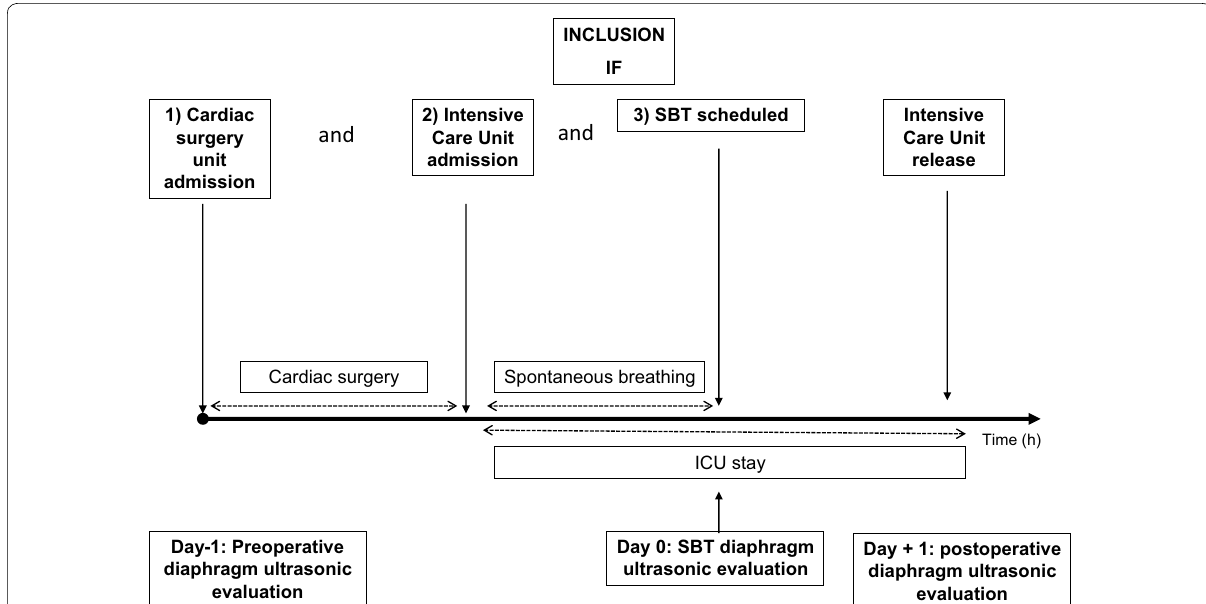
Fig. 1 Study protocol. Each patient hospitalized in cardiac surgery with elective cardiac surgery and ICU hospitalization was consecutively included when the diaphragm thickening fraction (TF) could be measured during spontaneous breathing trial (SBT). Preoperative (Day postoperative (Day 1) were measured when feasible to assess perioperative evolution. Diaphragm function was evaluated by the TF measured + on the right hemidiaphragm as reference in the same semi‑recumbent position. SBT: Spontaneous Breathing Trial; ICU: Intensive Care Unit; TF: diaphragm thickening